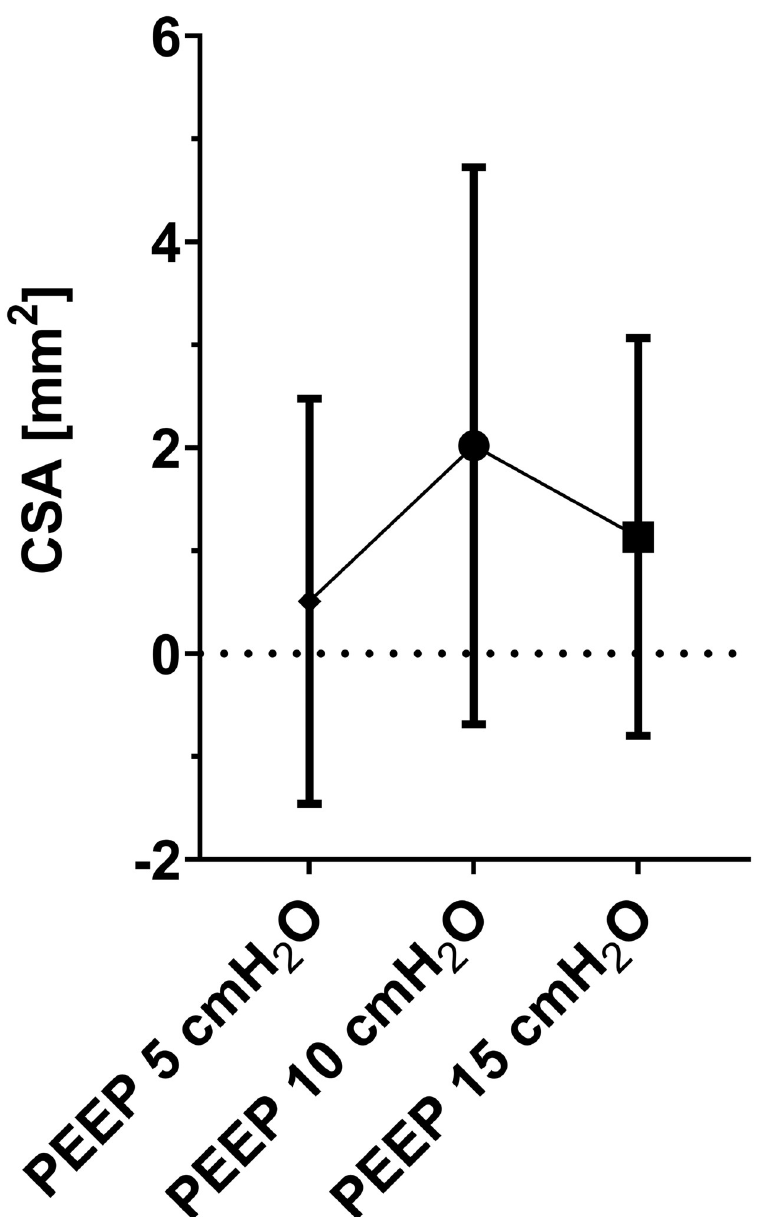
Fig 1. Change of the subclavian vein cross-sectional area (CSA) measured during different positive endexpiratory pressure (PEEP) steps. At each PEEP step, the measured CSA at PEEP 0 cm H 2 O was subtracted from the measured CSA value at the PEEP step. All values were pooled for the left and the right body side and are shown as means and standard deviations.